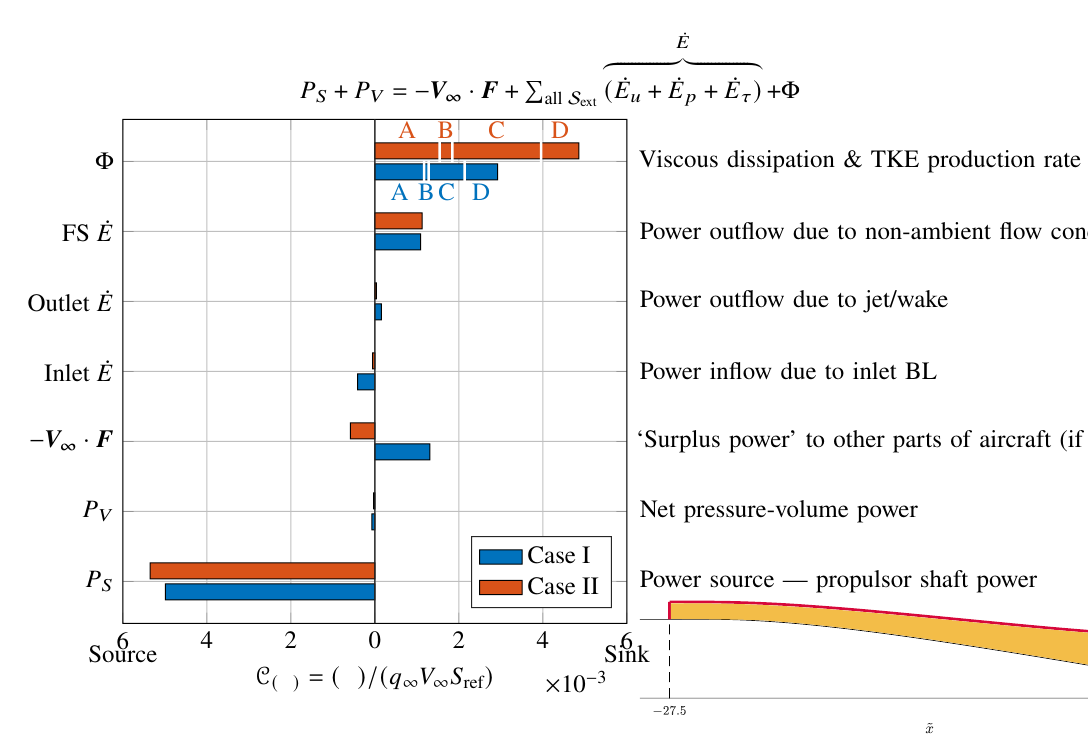
Figure 18. Mechanical power balances for CV been broken down into the contributions from the four regions in the